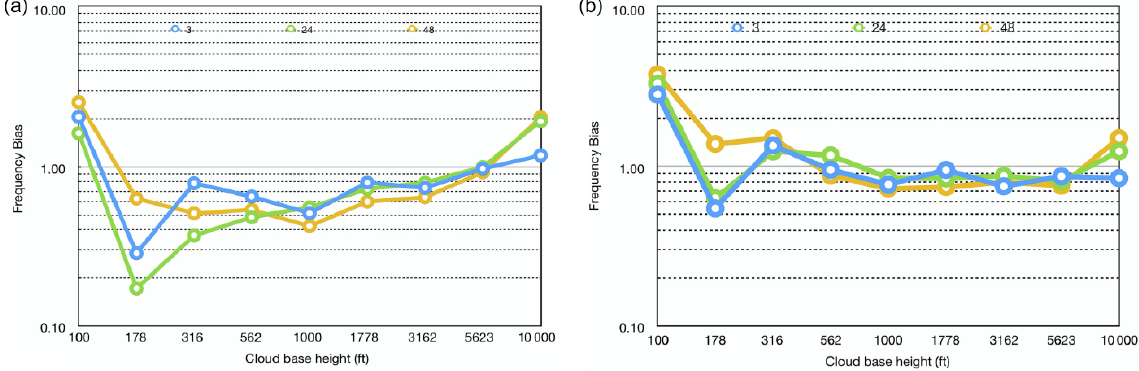
Figure 20. Frequency bias of the cloud base height in feet (1ft is 0.3048m) for December 2018 with cy40REF (a) and cy40NEW (b) . Blue, green, and orange lines refer to + 3, + 24, and + 48h forecasts,